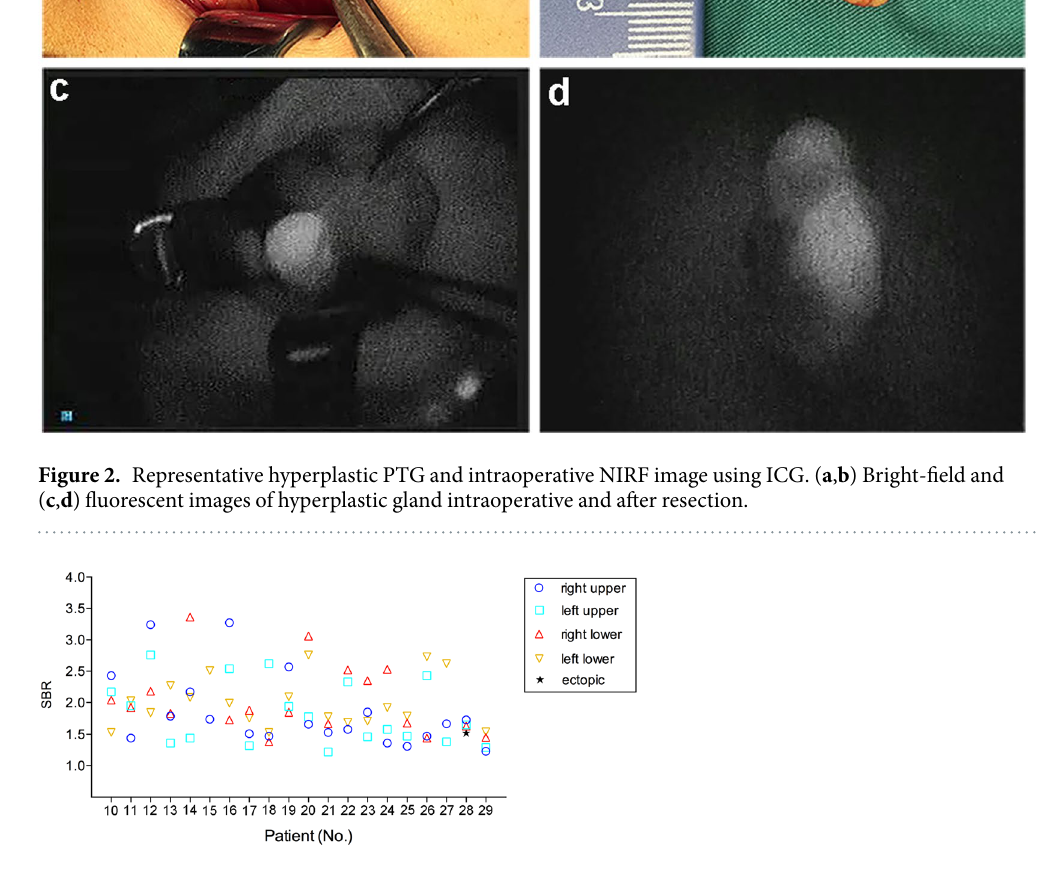
Figure 3. The SBR distribution of total 77 resected glands of 20 patients with intraoperative NIRF image using